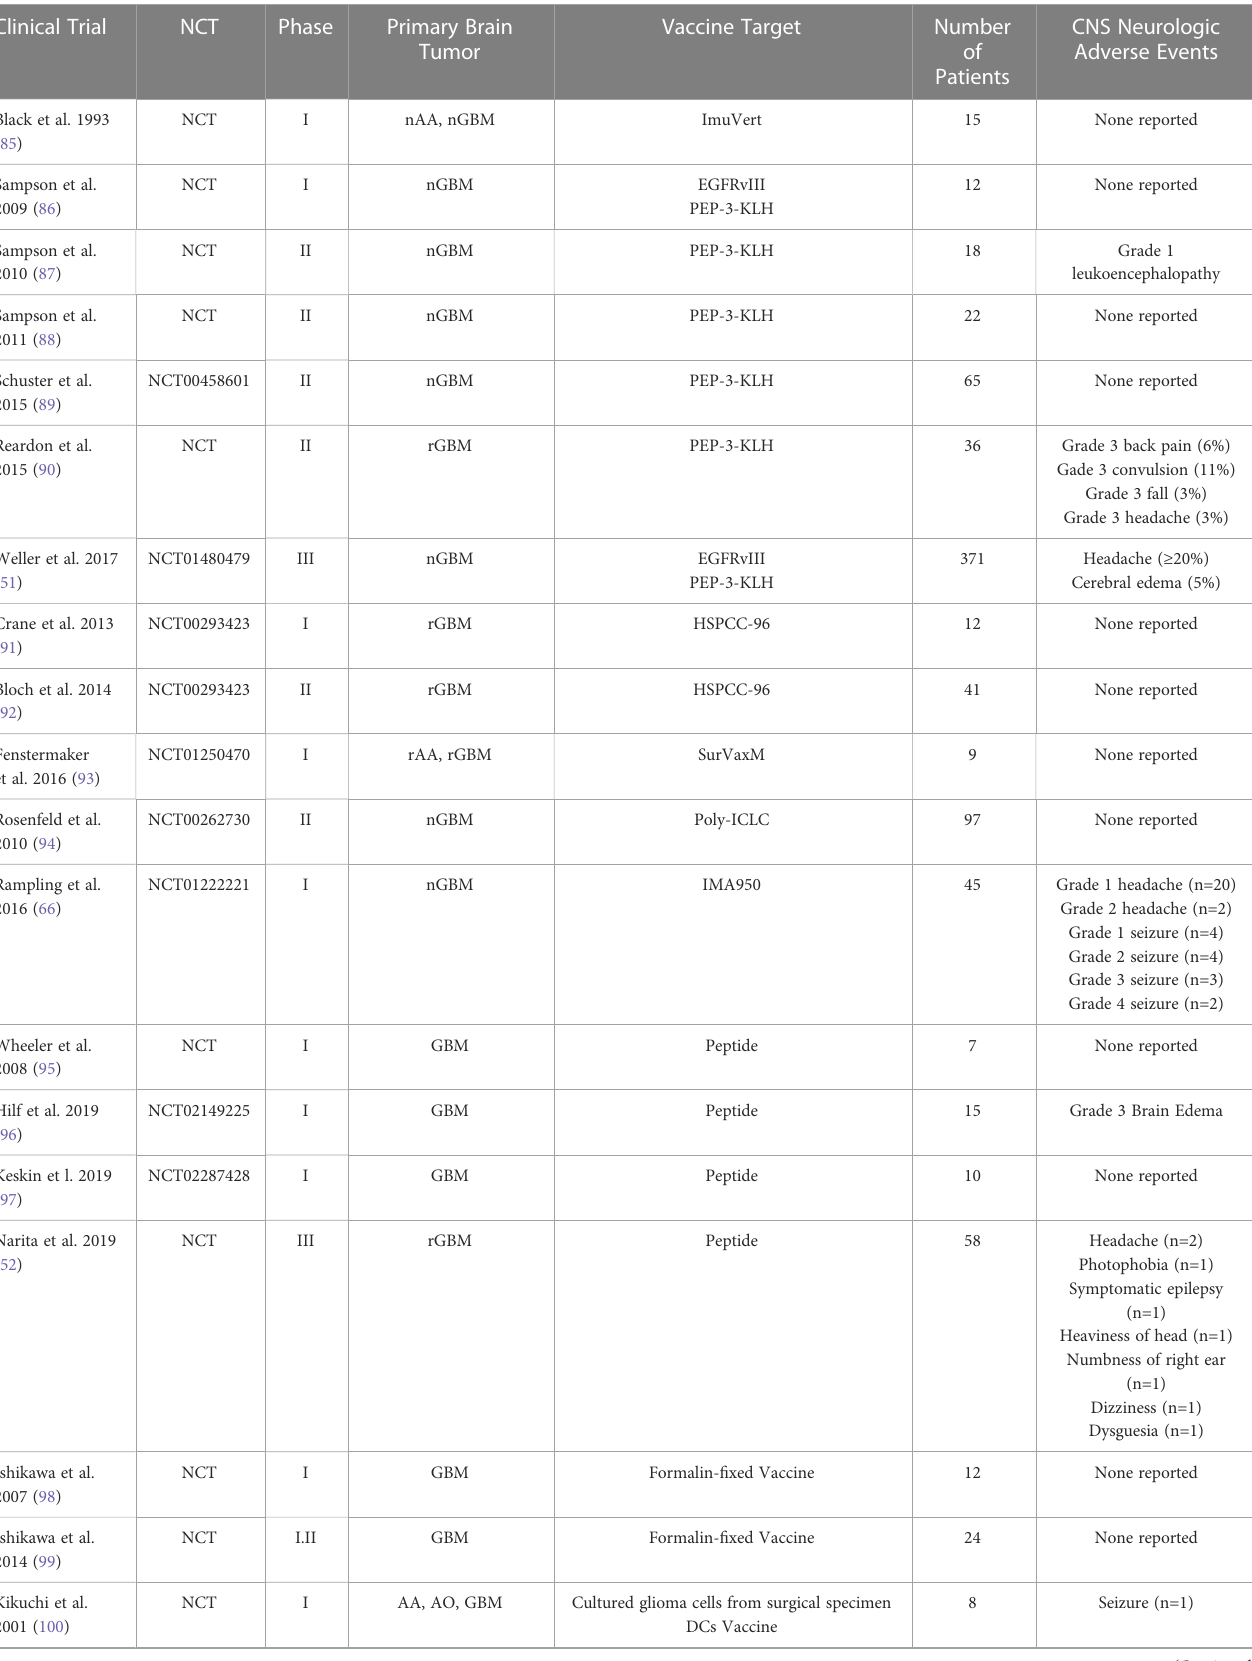
TABLE 2 CNS Toxicity of Primary Brain Tumor Vaccine